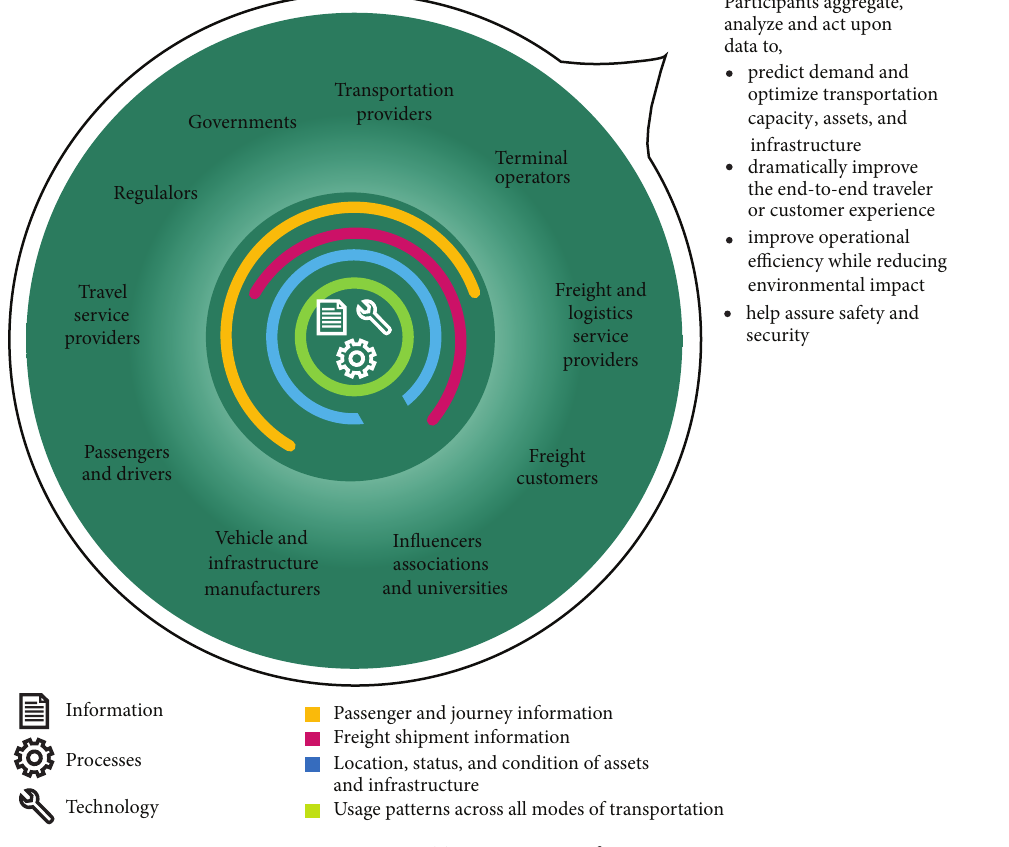
Figure 1: Smarter Transportation Information.